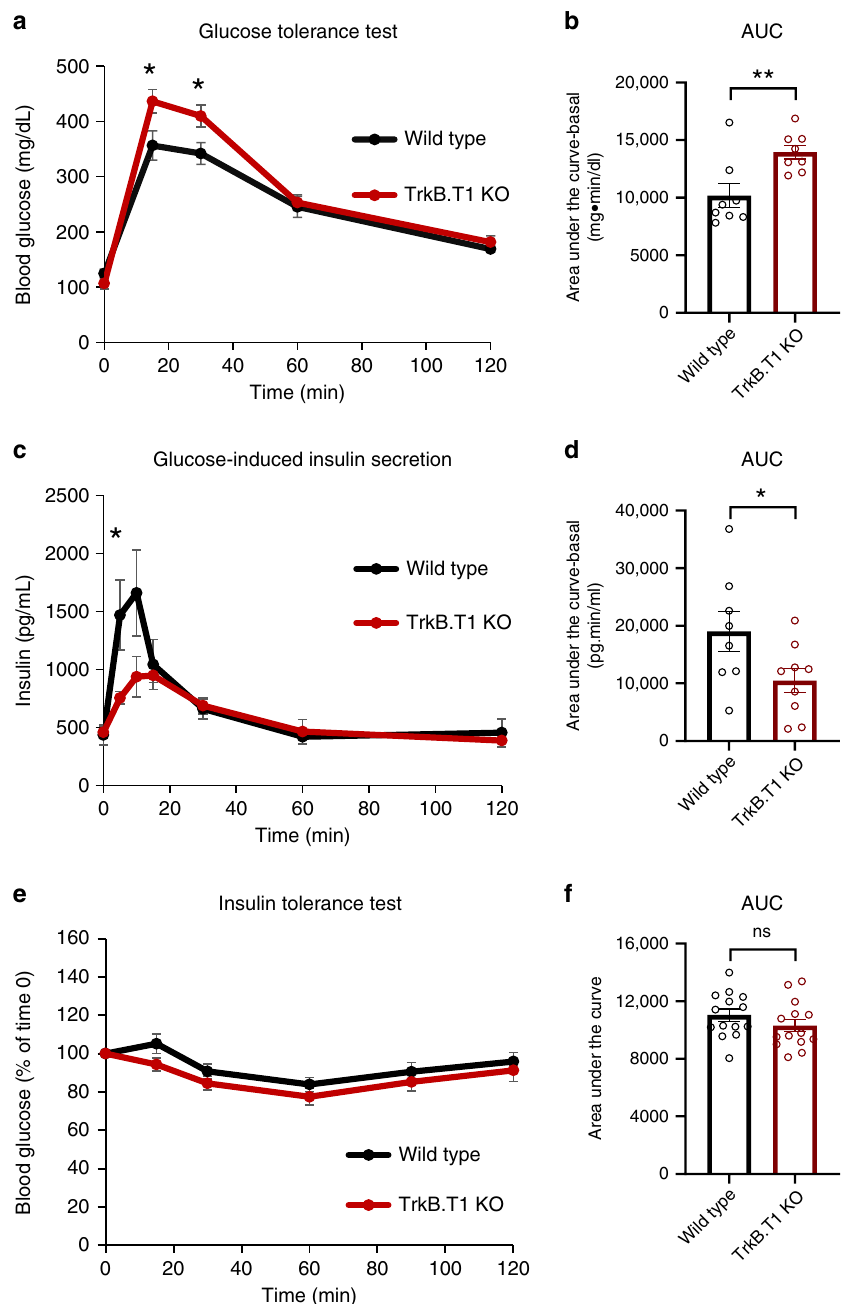
Fig. 2 Mice lacking TrkB.T1 have impaired glucose metabolism. a – d Blood glucose ( a , b ) and insulin ( c , d ) levels in TrkB.T1 KO and control mice subjected to an oral glucose tolerance test (2 g/kg of glucose), WT n = 8, TrkB.T1 KO n = 8 in a and WT n = 8, TrkB.T1 KO n = 9 in c . b , d Area under the curve (AUC) for the exogenous glucose induced increments of plasma glucose ( b ) and insulin ( d ); * p < 0.05, ** p < 0.01 (Student ’ s t -test). e , f Insulin tolerance test in WT and TrkB.T1 KO mice. Time course ( e ) and AUC ( f ) of blood glucose concentration after a bolus of 0.75 unit/kg insulin was intraperitoneally injected at time 0; WT n = 14, TrkB.T1 KO n = 14. Data represent mean ± S.E.M. Source data are provided as a Source Data fi